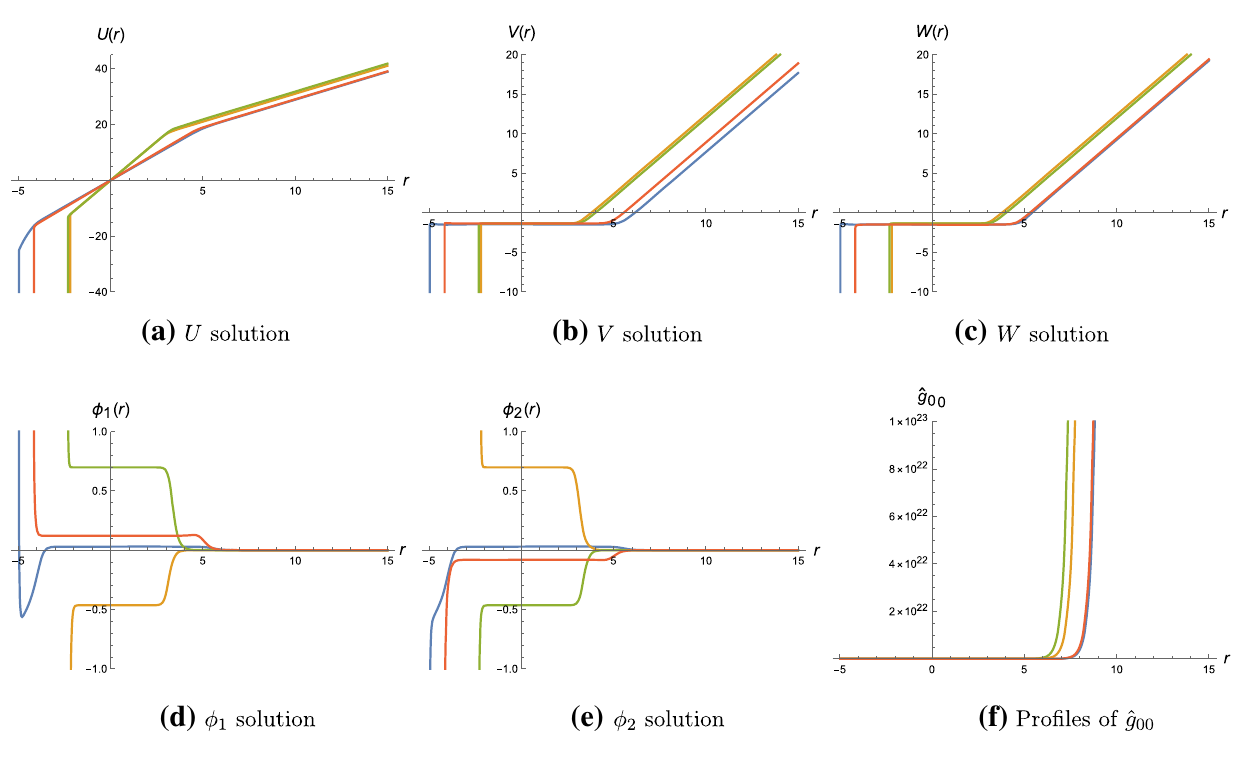
g = 16 and different values of z 1 and z 2 are given in Figs. 18, 19 and 20. We see that all singularities in the flows from AdS 3 × S 2 × R 2 fixed points are unphysical while only the singularities on the right (left) with φ 1 → ∞ and φ 2 → −∞ ( φ 1 → −∞ and φ 2 → ∞ ) in the flows from AdS 3 × S 2 × S 2 ( AdS 3 × S 2 × H 2 ) fixed points are